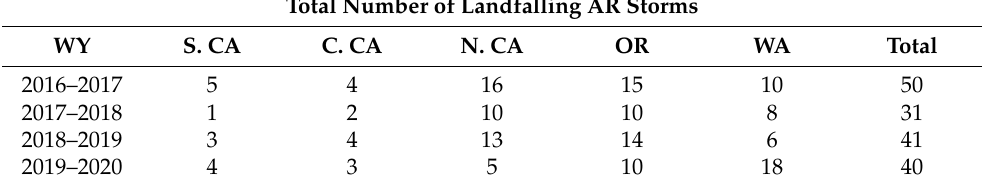
Table 6. Number of landfalling Atmospheric Rivers (ARs) along the western US, broken into five separate locations Southern California (S. CA), Central California (C. CA), Northern California (N. CA), Oregon (OR), and Washington (WA).